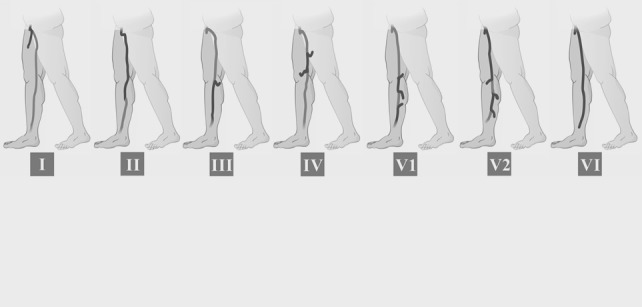
Patterns of reflux in the great saphenous vein: I) Medial junction reflux pattern; II) Proximal reflux pattern; III) Distal reflux pattern; IV) Segmental reflux pattern; V1) Multisegmental pattern without reflux at SFJ; V2) Multisegmental pattern with reflux at SFJ; VI) Diffuse reflux pattern.